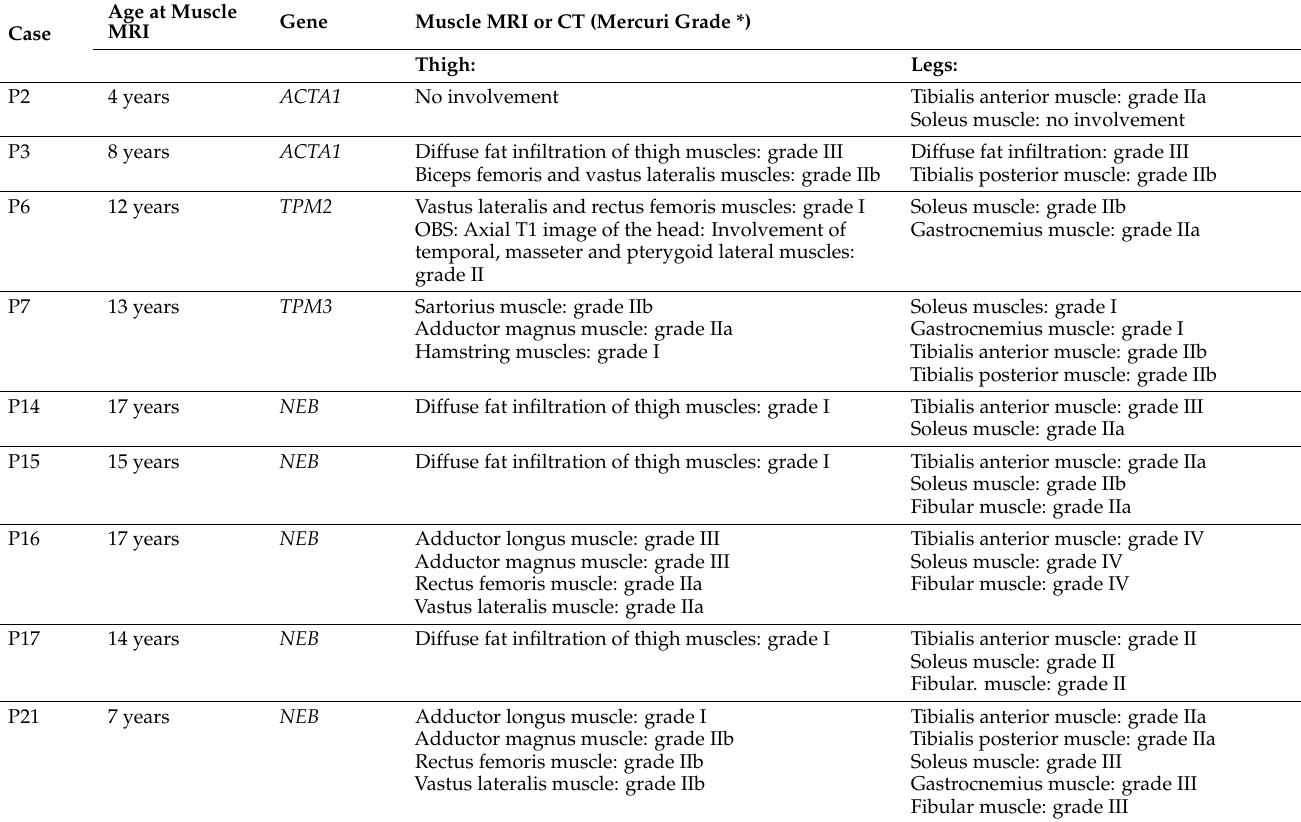
Table 2. Muscle MRI: Pattern of muscle involvement in nemaline